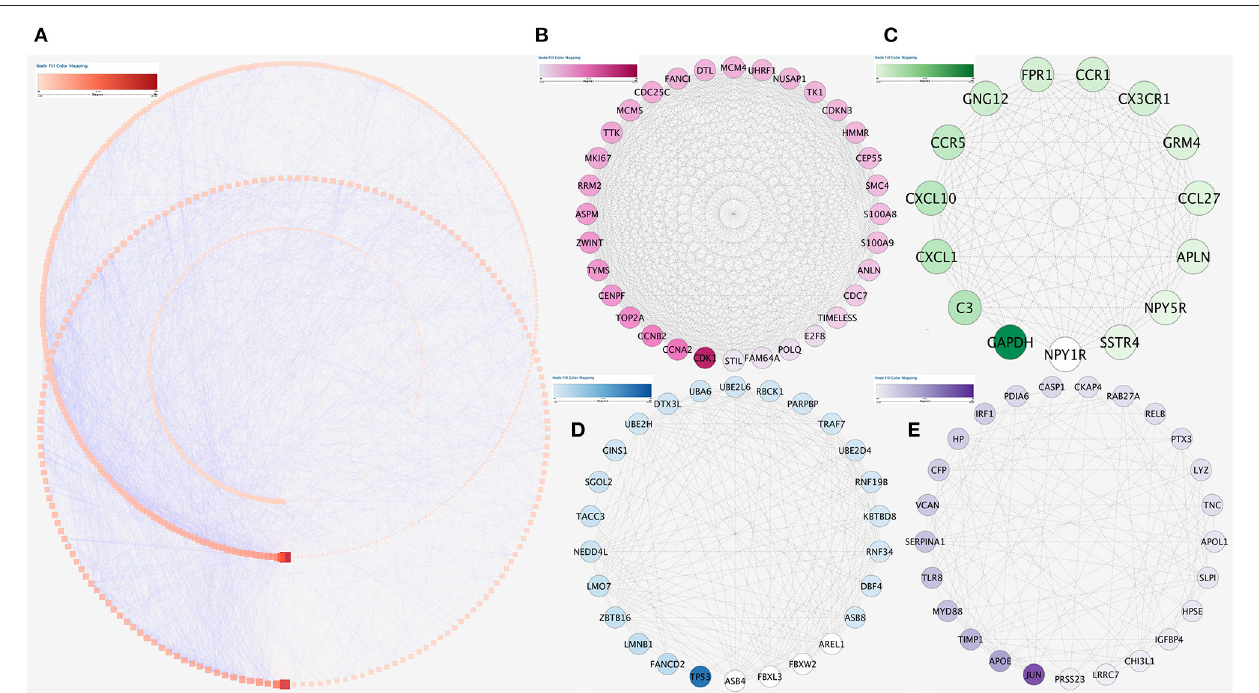
FIGURE 6 | Protein–protein interaction network analysis. (A) Protein–protein interaction network of the module genes. Edge stands for the interaction between two genes. A degree was used for describing the importance of protein nodes in the network; darkness red shows a high degree and light presents a low degree. (B–E) The significant modules identified from the protein–protein interaction network using the molecular complex detection method with a score of > 8.0. MCODE B score = 22.166, MCODE